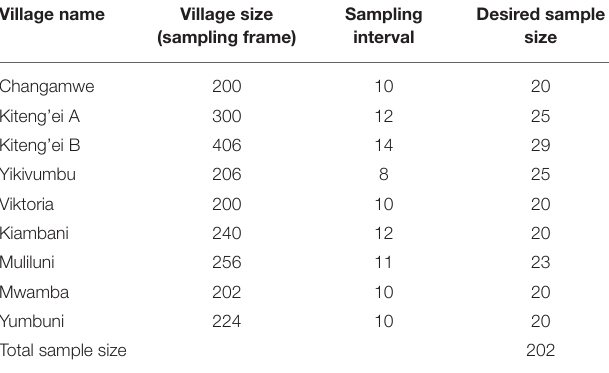
TABLE 2 | Number of farmers selected per